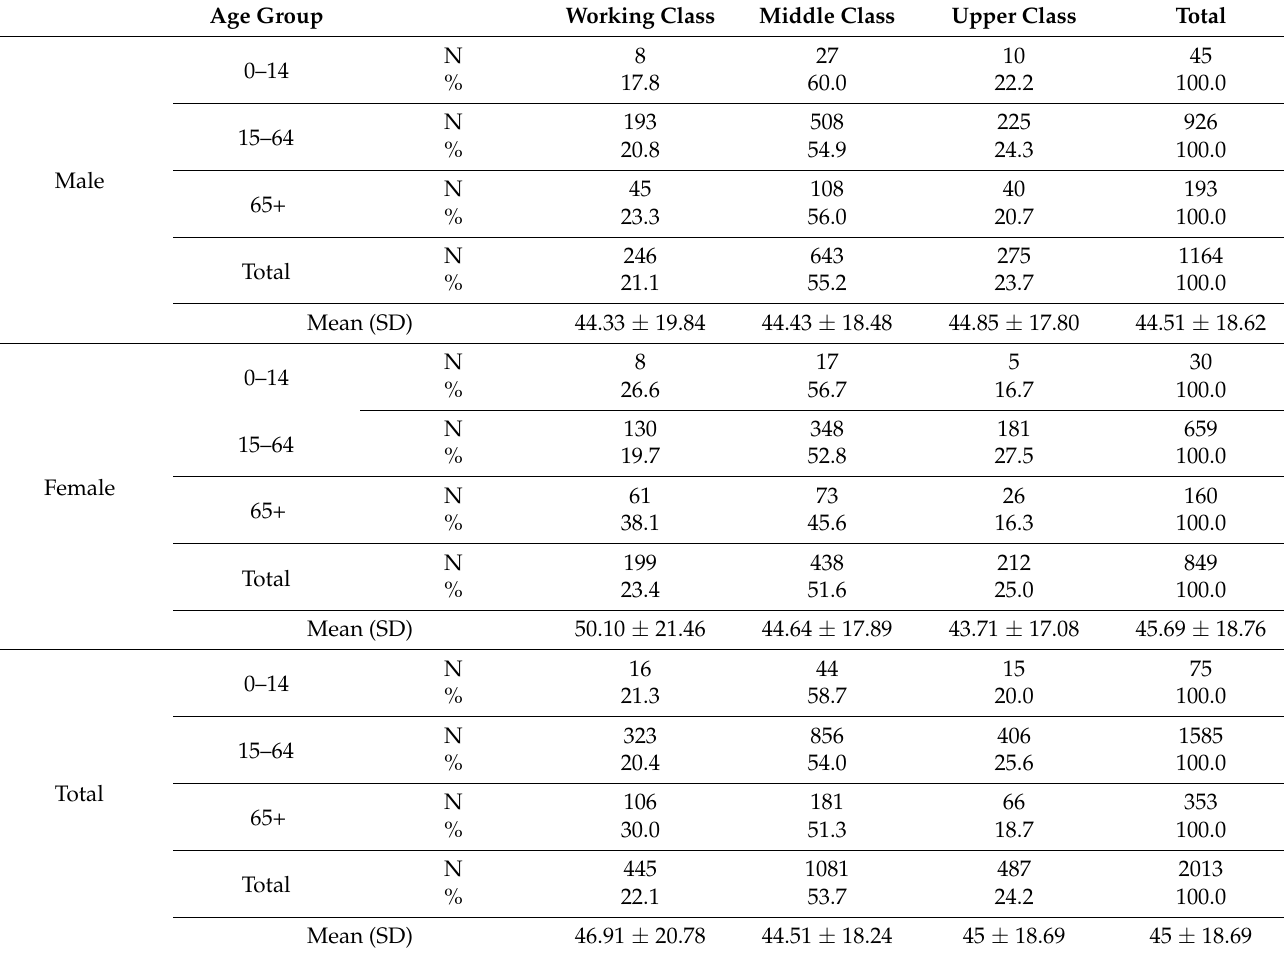
Table 1. Characteristics of patients with COVID-19 social classes in Kermanshah